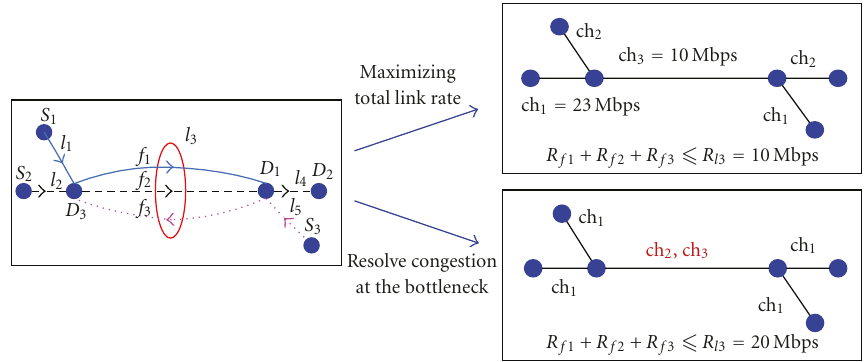
Figure 2: A simple network with its flow chart, and two channel assignment decisions.